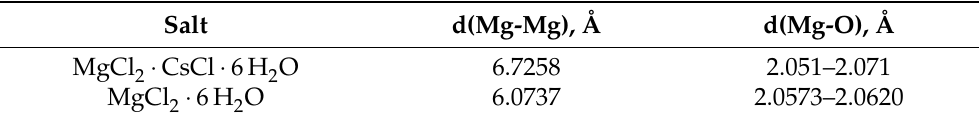
Table 2. The comparison of distances between neighboring atoms for simple MgCl double salt.